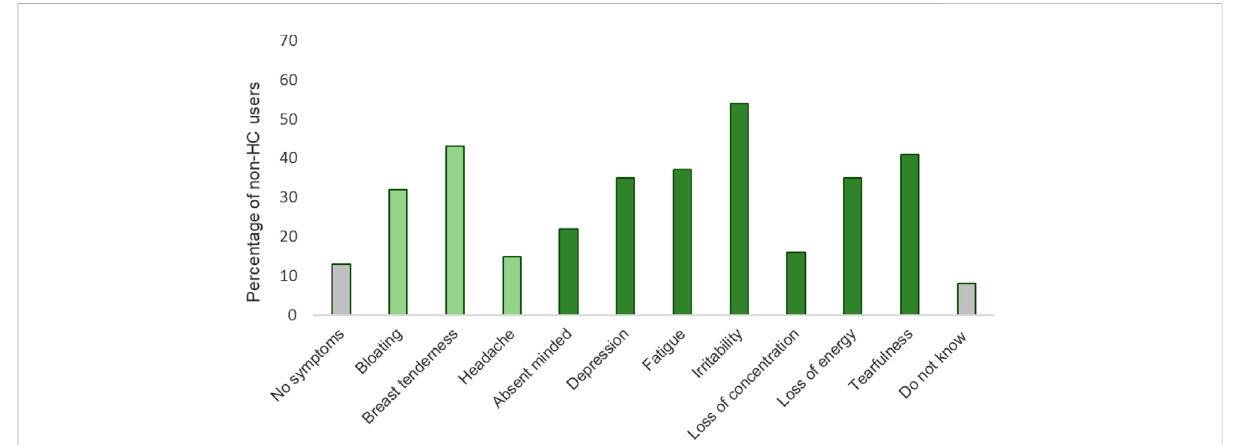
FIGURE 2 Premenstrual symptoms reported by the non-users ( n = 407) of hormonal contraceptives. Physical symptoms in light green and mental symptoms in green. Breast tenderness was the most frequent reported physical symptom (43%, n = 172) and irritability the most frequent reported mental symptom (54%, n = 214).